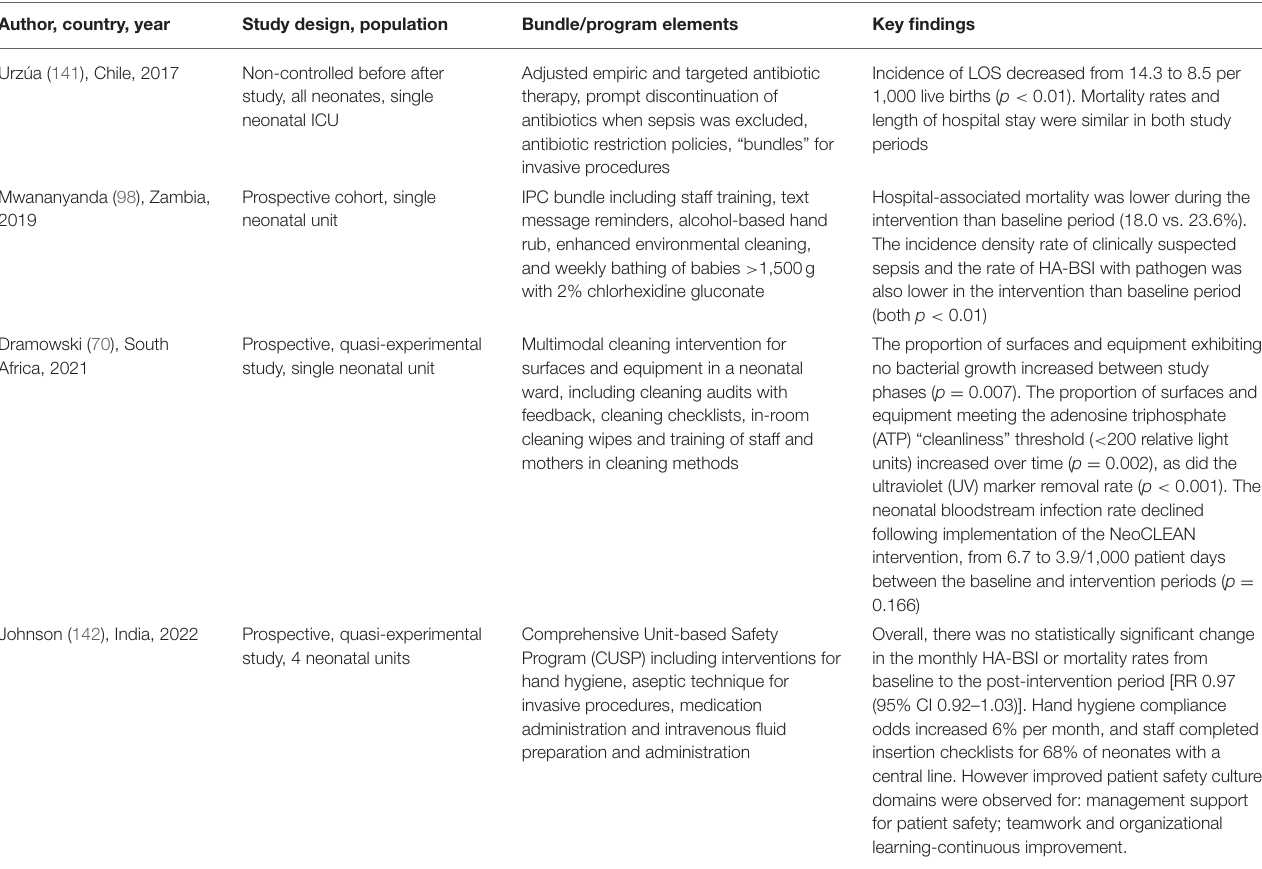
TABLE 1 | Selected healthcare-associated infection (HAI) prevention bundles and programs implemented in low- and middle-income country (LMIC) neonatal